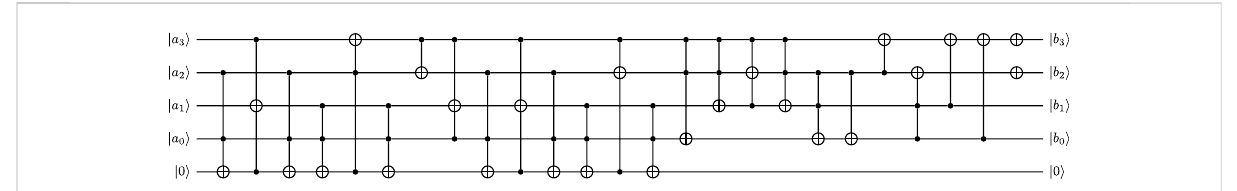
FIGURE 2 Quantum circuit of S-box used in SubCells: | a 〉 |0 〉 → | S ( a ) 〉 |0 〉 , where | a 3 〉 is the most signi fi cant qubit.